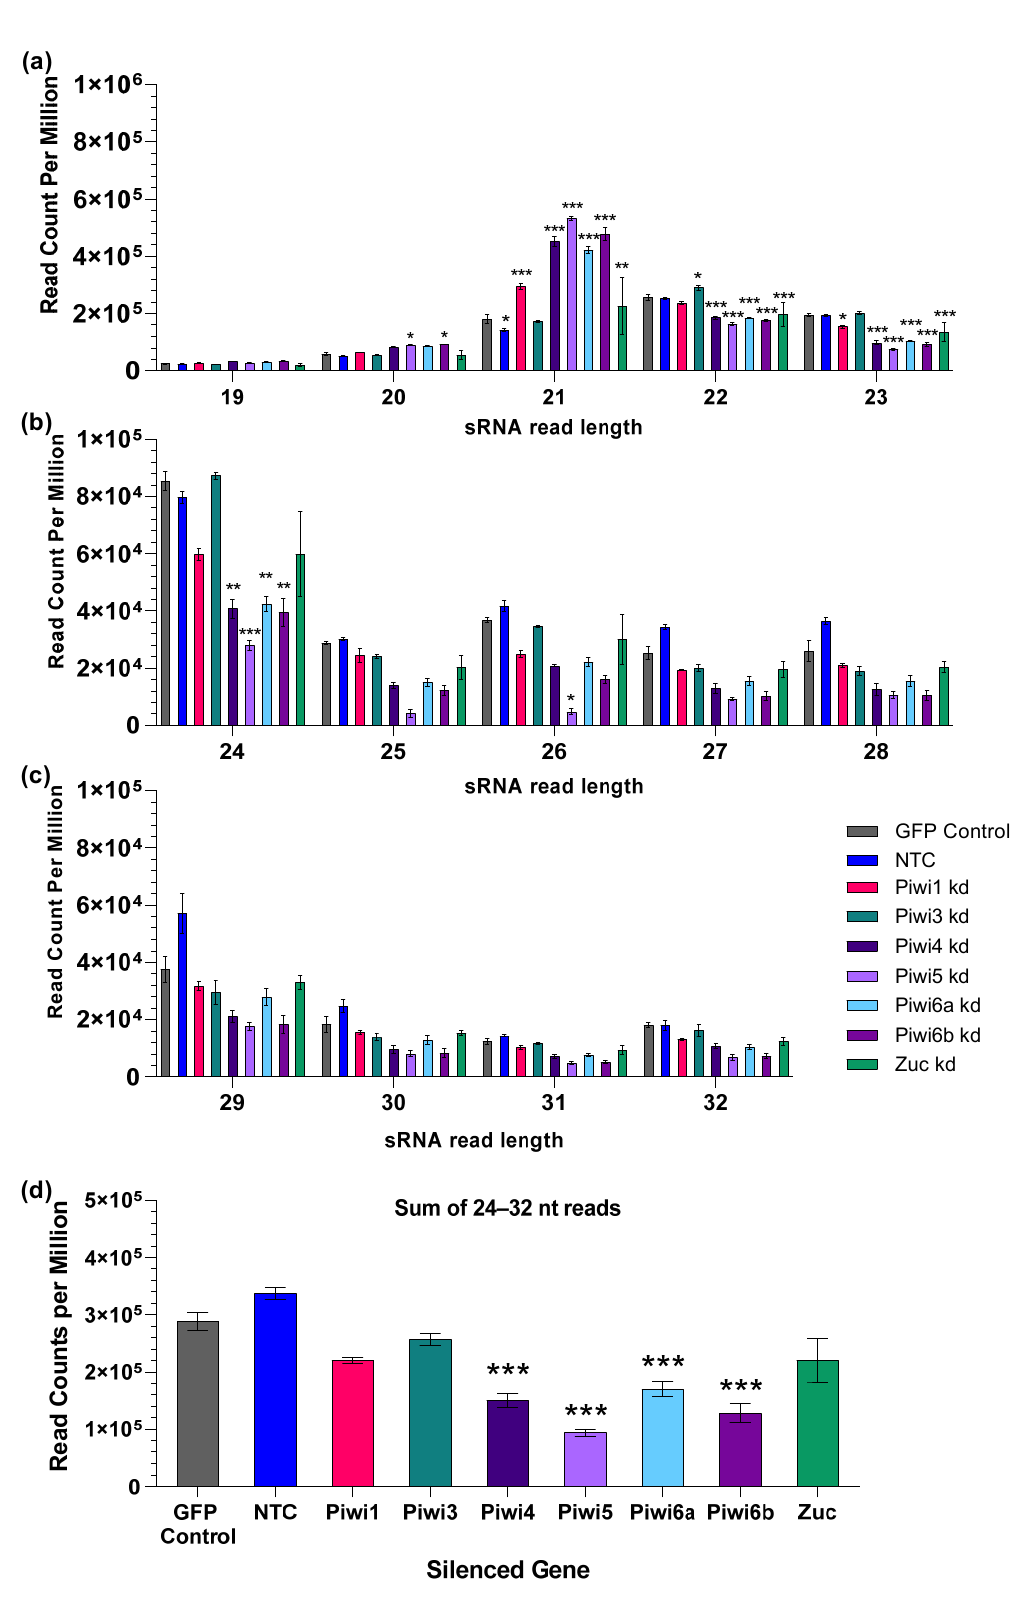
Figure 6. Total small RNAs in Cx. quinquefasciatus cells. sRNA libraries were sequenced from non-infected dsRNA-treated cells. All sRNAs (independent of sequence) from 19–32 nt length